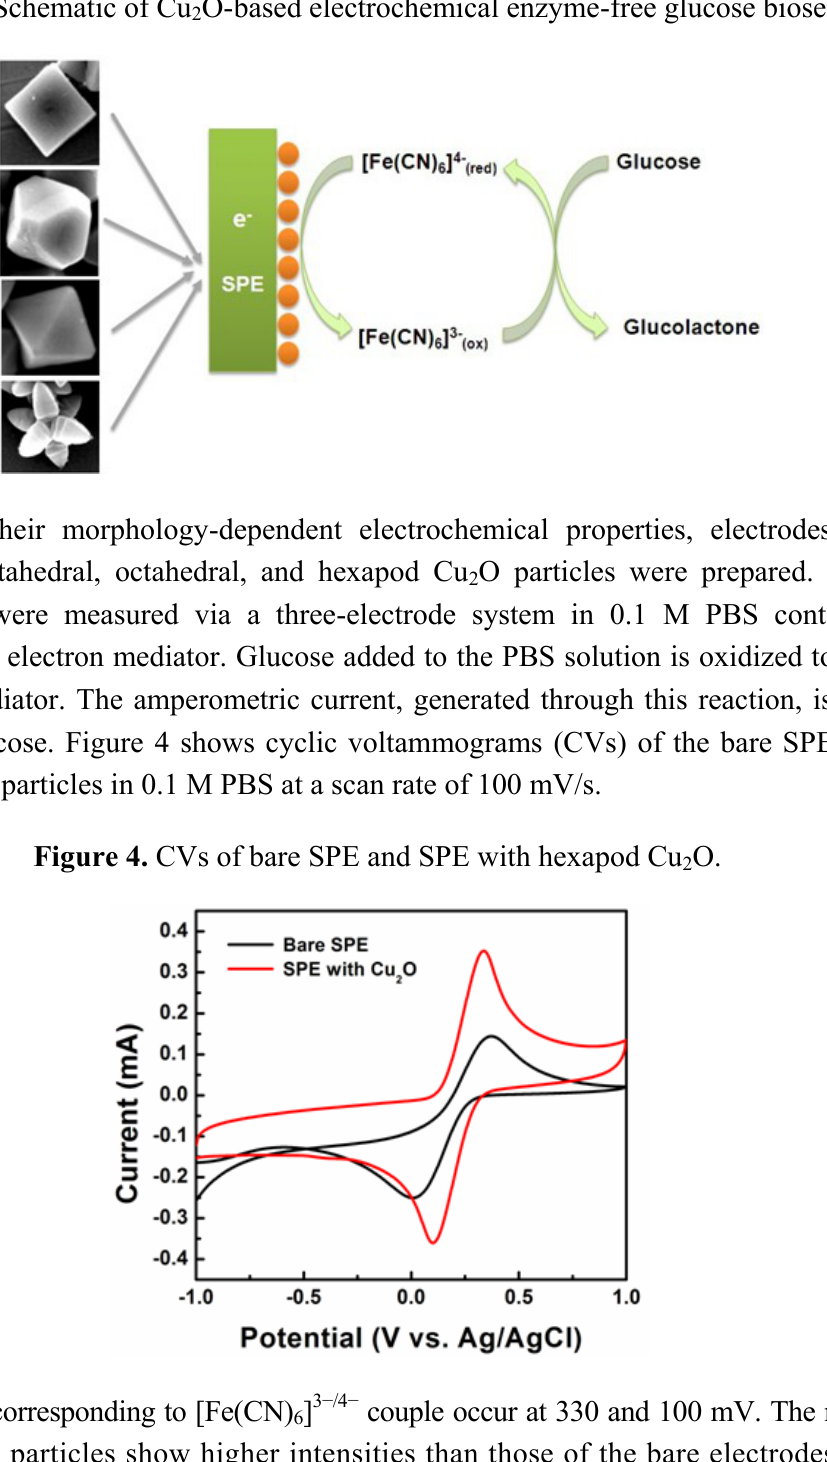
Figure 3. Schematic of Cu O-based electrochemical enzyme-free glucose biosensor. 2